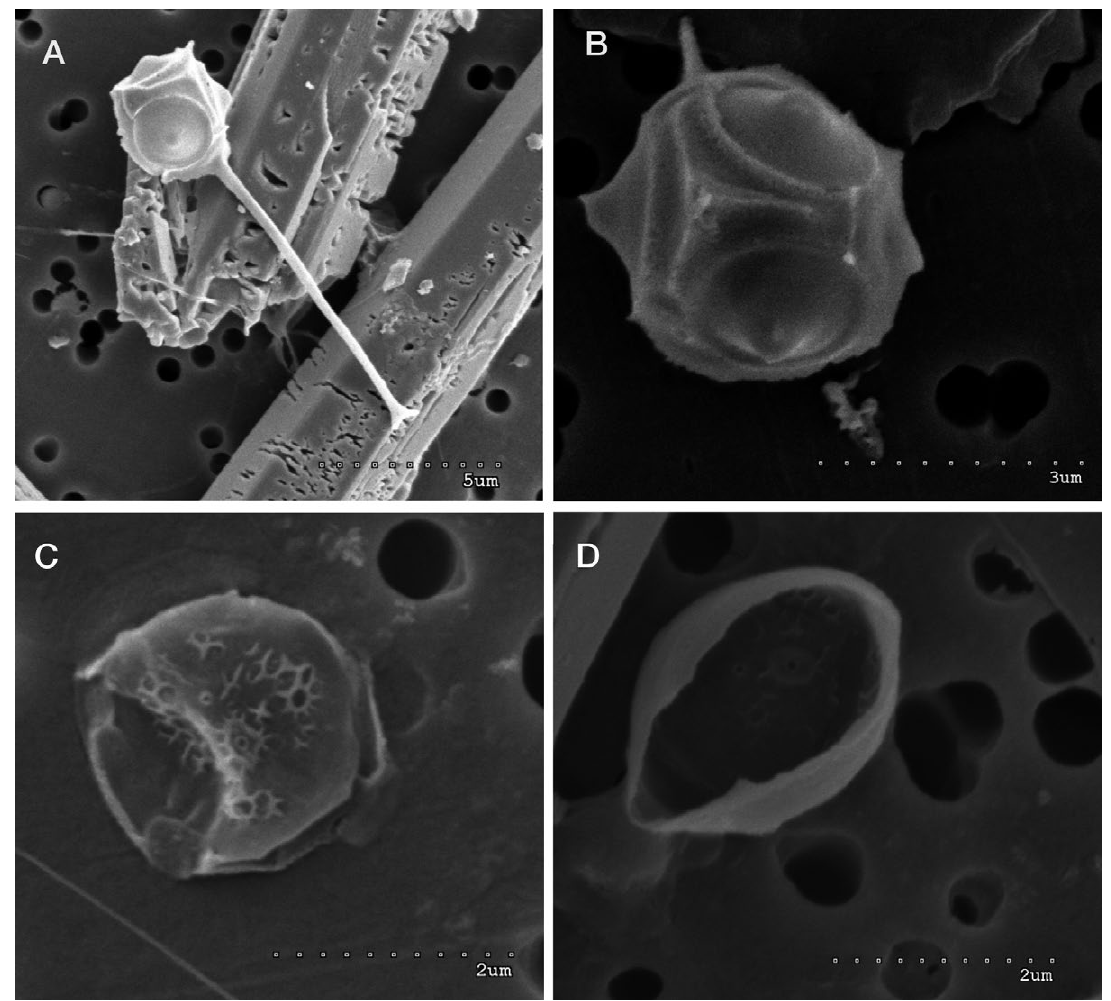
Fig. S4. – Scanning electron micrographs of Triparma laevis (Parmales) (A, B) and Minidiscus sp. (Bacillariophyceae) (C,